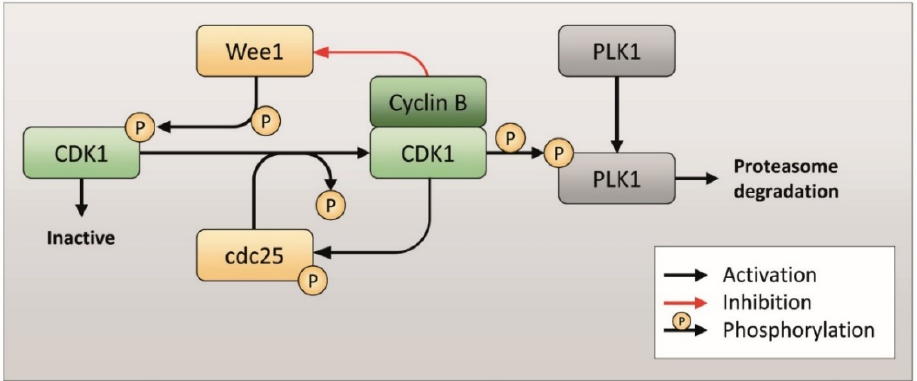
Figure 3. PLK1 phosphorylation and proteasome degradation pathway.